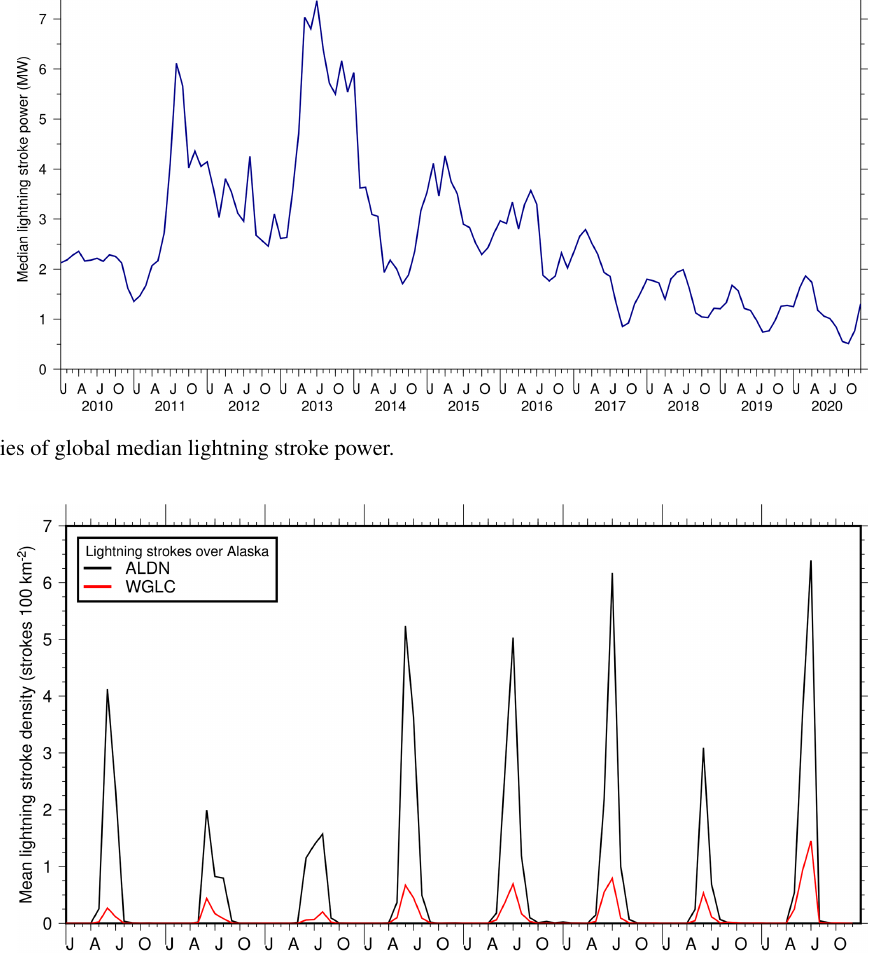
Figure 11. Time series of monthly mean lightning density over Alaska. Alaska Lightning Detection Network (black line: ALDN cloud-to- ground strokes) and WGLC (red line). Both datasets were gridded on the same 10km equal-area